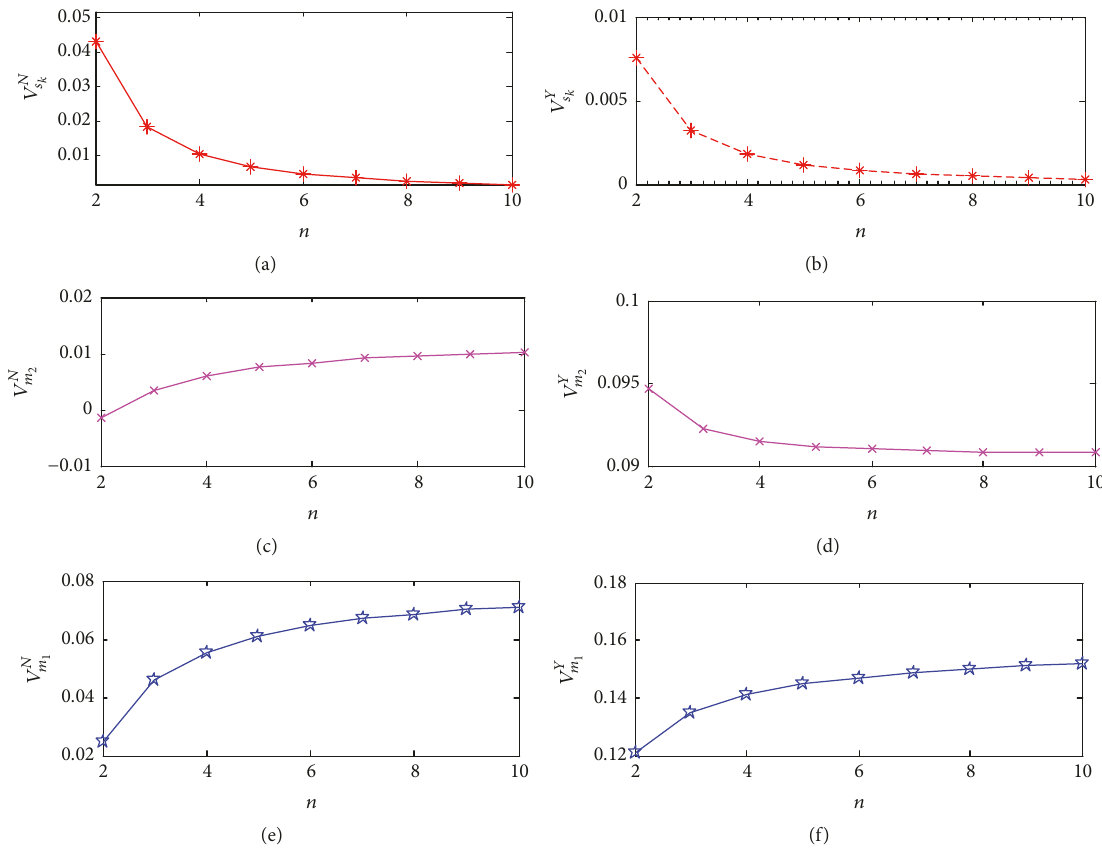
Figure 4: The impact of 𝑛 on 𝑉 𝑁 𝑠